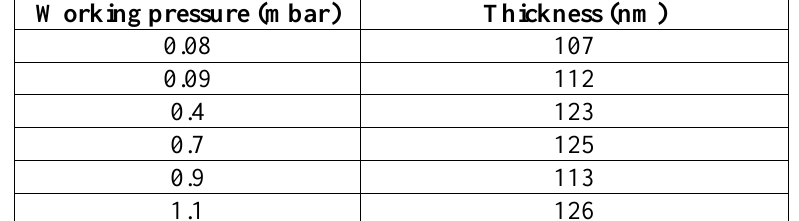
Table 1: The Thickness of Ag thin films deposited at different working pressure.